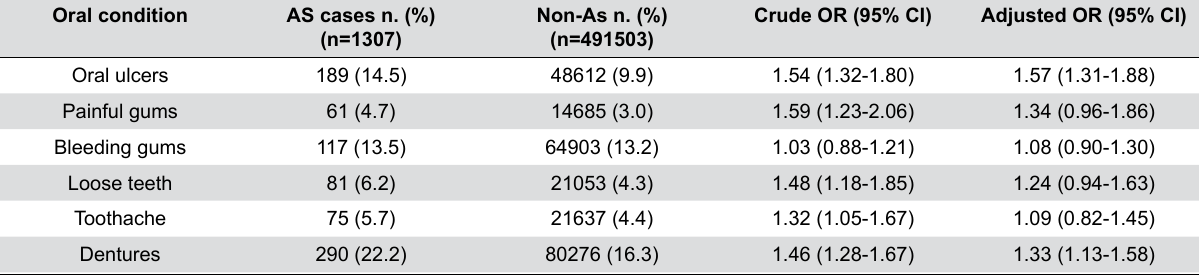
Table 2- Prevalence of self-reported oral health conditions in self-reported AS and non-AS populations